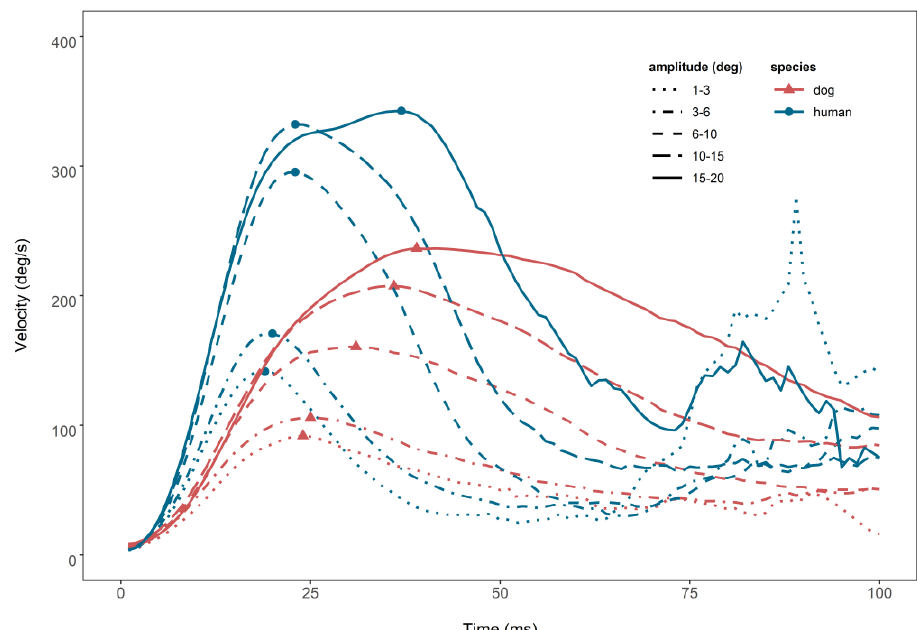
Figure 3. Comparison of saccadic velocity profiles of human and dog saccades in different amplitudes. The same patterns of velocity profiles as in the Figure 1 in Collewijn, Erkelens, & Steinman (1988) can be observed in both species saccades. The amount of ac- celeration duration (P<0.0001) and the duration of deceleration (P<0.002) increased for saccades that have bigger amplitudes in both species. However, human saccades more quickly accelerated to the peak velocity with increasing amplitude (P < 0.002) than dog saccades. Also, human saccades overall took less to decelerate than dog saccades (P < 0.002). Each profile line plots velocity means of each species saccades of a given amplitude. Solid symbols (triangles and points) indicate peak velocities of the